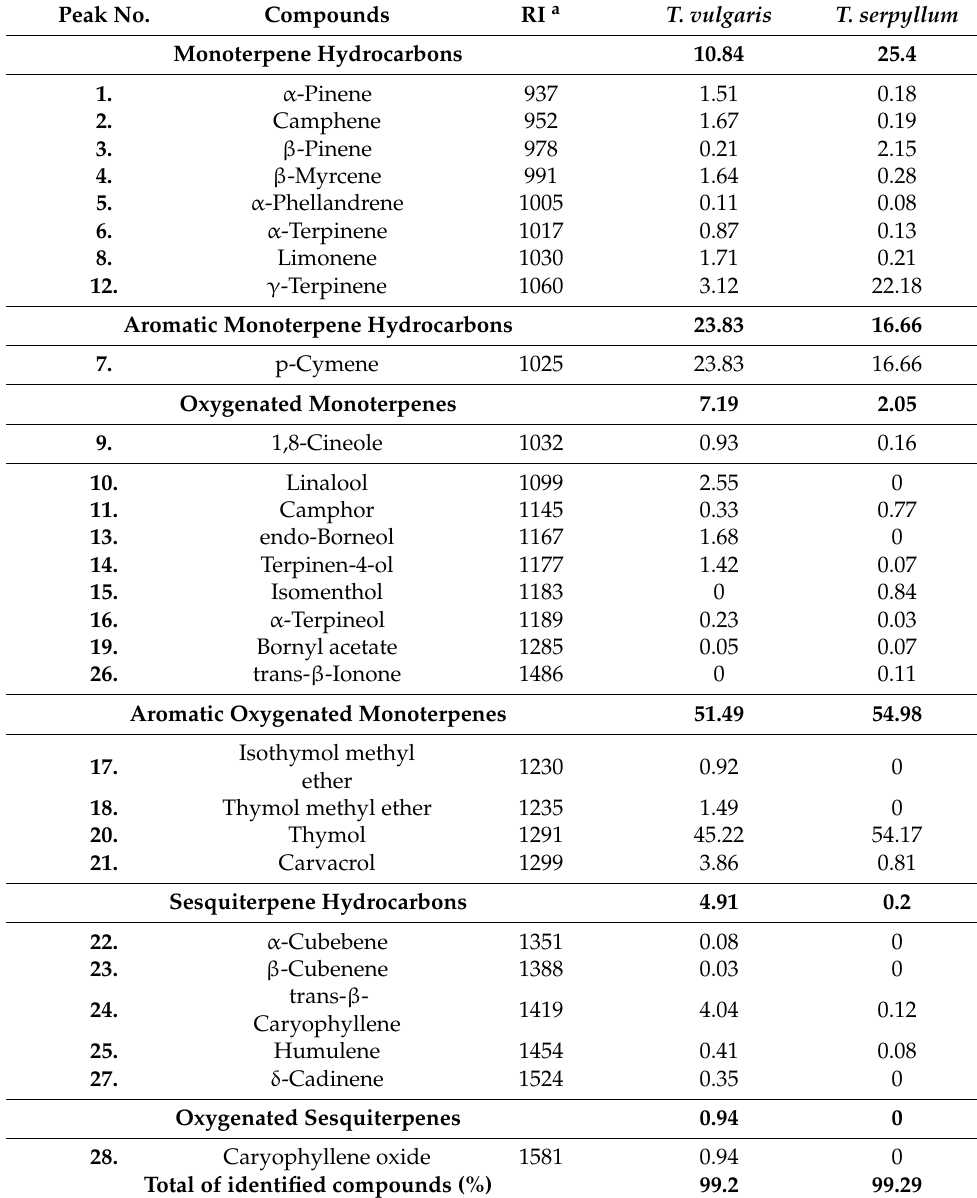
Table 2. Chemical composition of T. serpyllum and T. vulgaris essential oils (EOs) (%). Peak